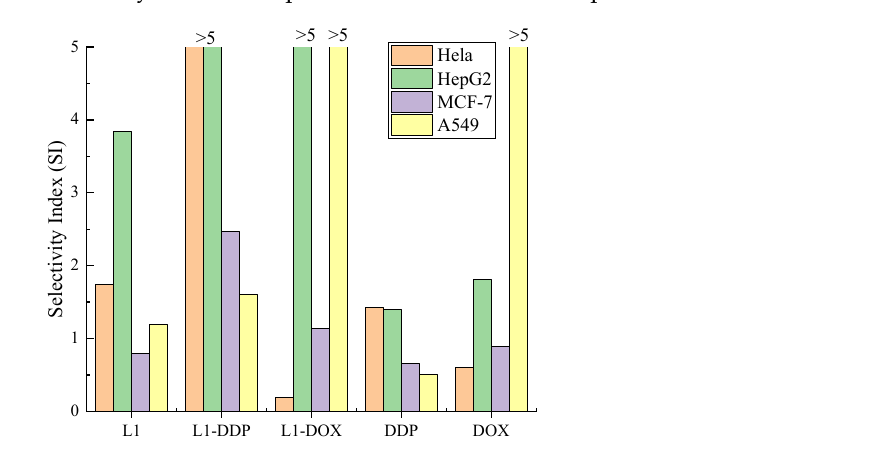
Figure 2. The selectivity index (SI) of L 1 , DDP, DOX, L 1 -DDP, and L 1 -DOX. (SI = (IC 50 for normal cell line HUVEC)/(IC 50 for human tumor cell line)).